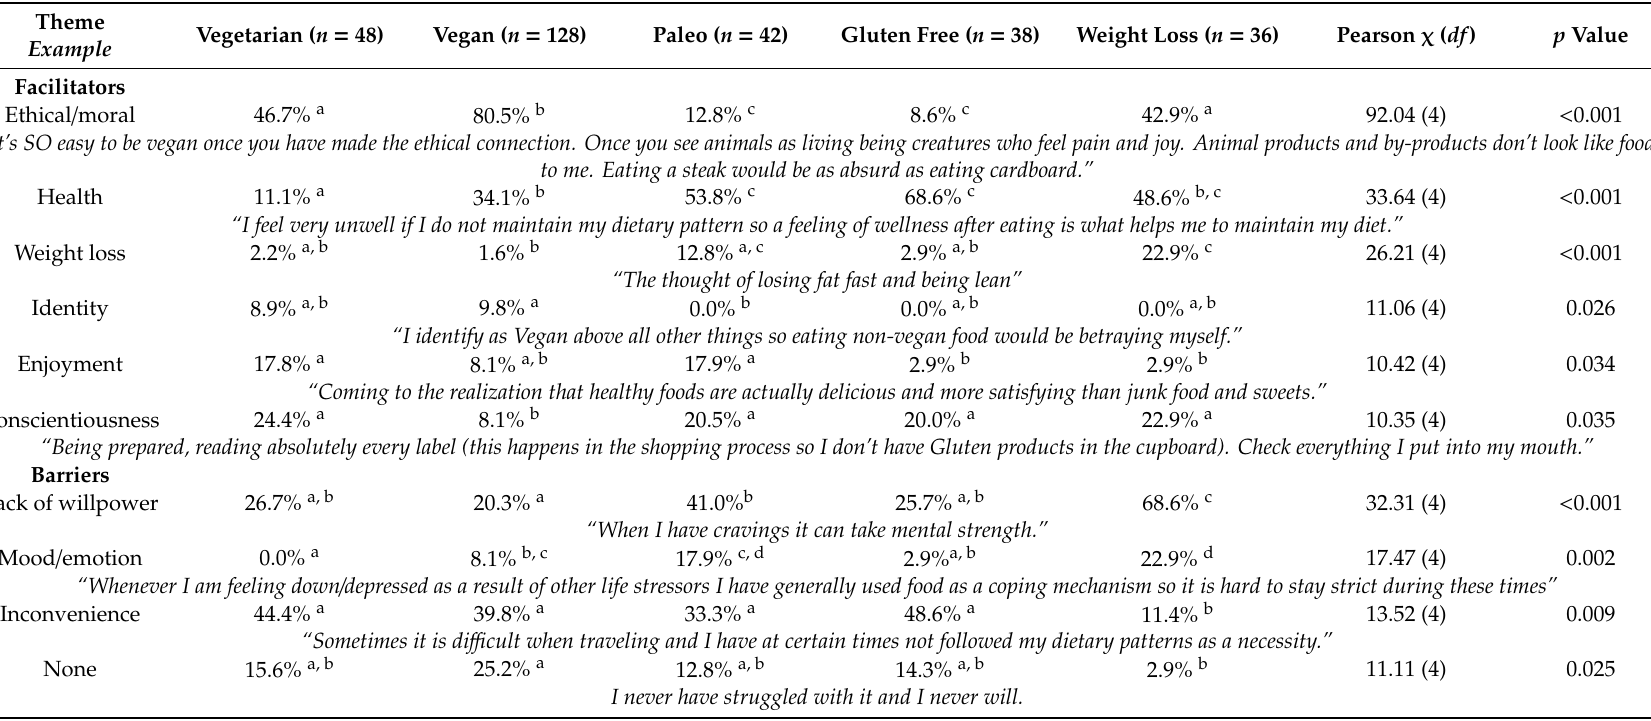
Table 1. Frequency of each theme in qualitative description of barriers and facilitators of adherence among each dietary group.